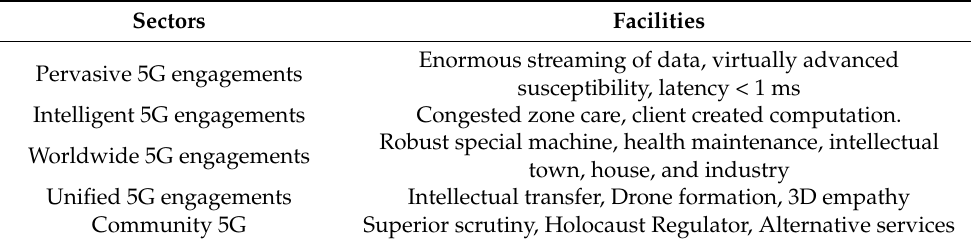
Figure 2. Role of FBMC in Smart hospitals. Table 2. Expectation from 5G services for modern hospitals.